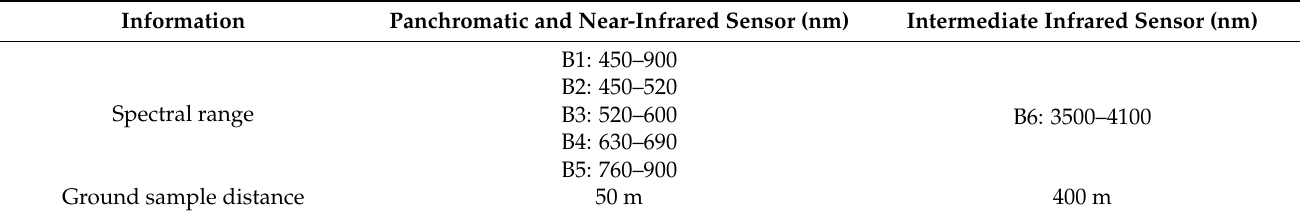
Table 1. Information for the GF-4 of sensors.